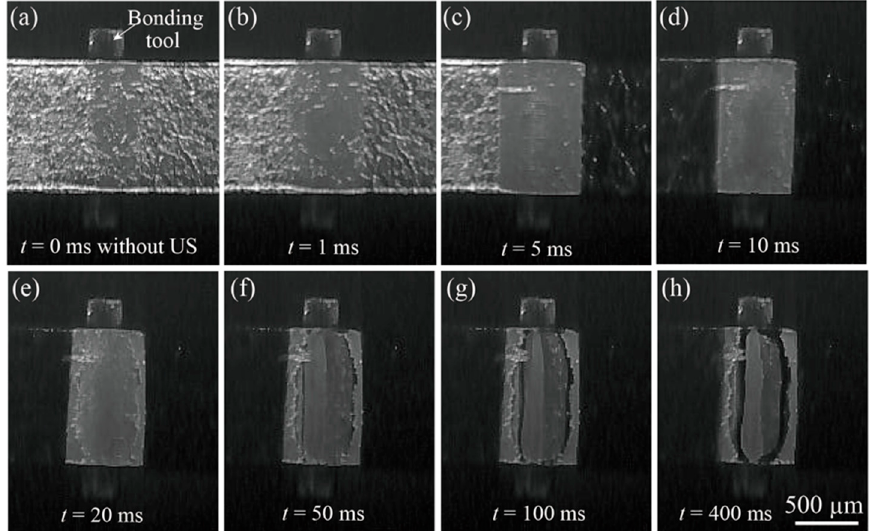
Figure 10. In-situ observation results (video captures) of the bonding interface between Al ribbon and silica substrate obtained at F rate = 10 3 fps. The bonding condition was F b = 7 N and P u = 4 W. Simultaneous measurement result of ultrasonic vibration amplitude is shown in Figure 3 (b–2): ( a ) t = 0 ms without ultrasonic vibration (US); ( b ) t = 1 ms immediately after introducing US; ( c ) Apparent bonded area increased at t = 5 ms; ( d ) Apparent bonded area decreased at t = 10 ms due to Al ribbon warping; ( e ) t = 20 ms; ( f ) Central belt zone began to be observed at t = 50 ms; ( g ) t = 100 ms; ( h ) t = 400 ms.